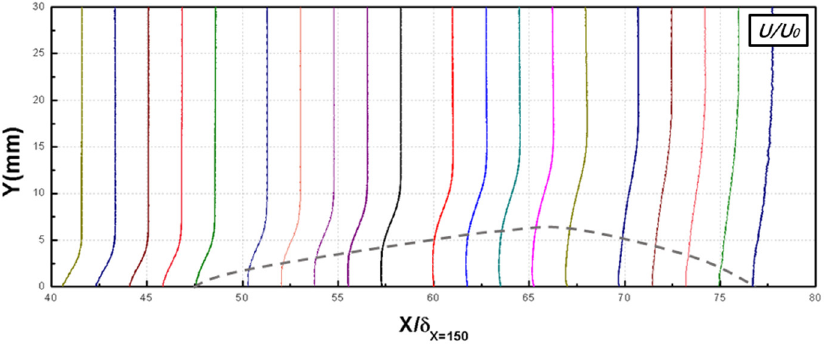
Figure 6. Normalized velocity of the boundary layer.